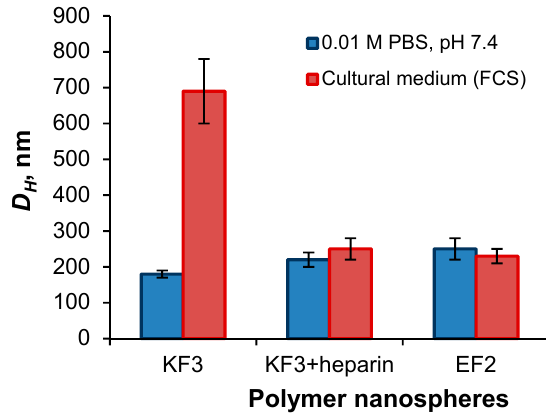
Figure 11. Stability of different nanospheres in culture medium.